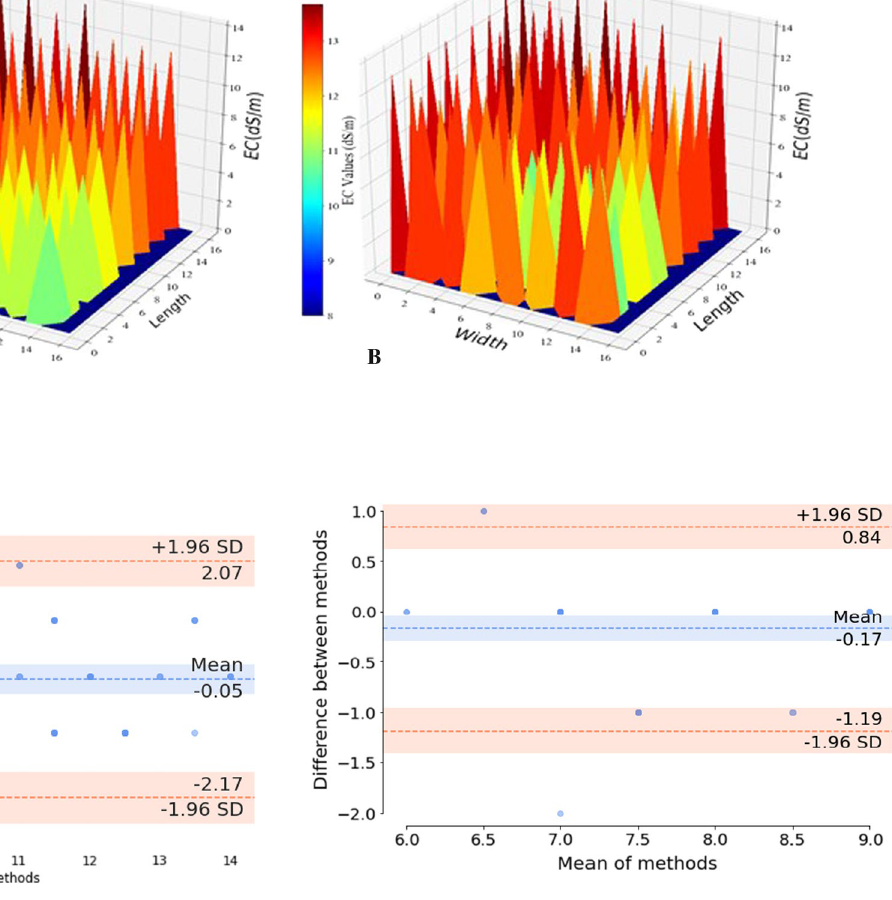
Fig. 9 Bland Altman difference plot for pH